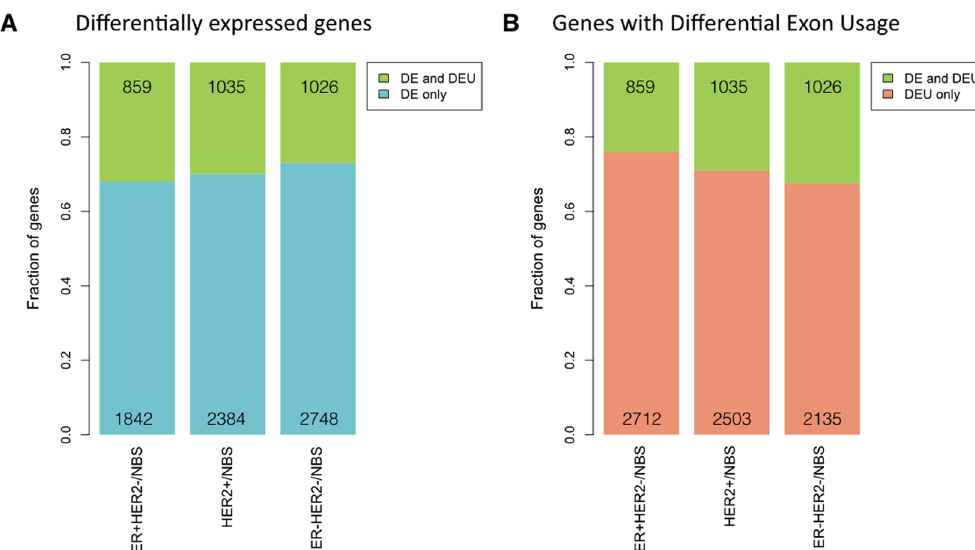
Figure 3. Alternative exon usage in differentially expressed genes in tumor subtypes compared to NBS. The fractions of overall differentially expressed genes with differential exon usage (DEU), or differential gene expression (DE) only are shown in ( A ). The numbers of genes in each category are included in the bar graph. The fraction and numbers of genes with DEU that; either show DEU only, or are also part of overall DE genes are shown in ( B